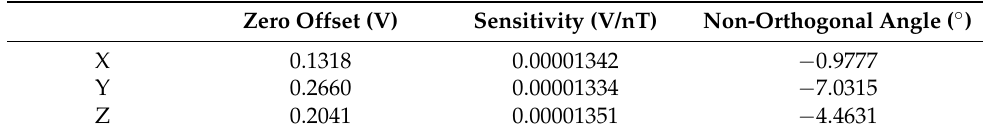
Figure 10. Ellipsoid fitting graph of magnetometer. Equivalent zero offset, equivalent sensitivity and equivalent non-orthogonal angles are shown in Table 6. Table 6. Results of ellipsoid fitting.